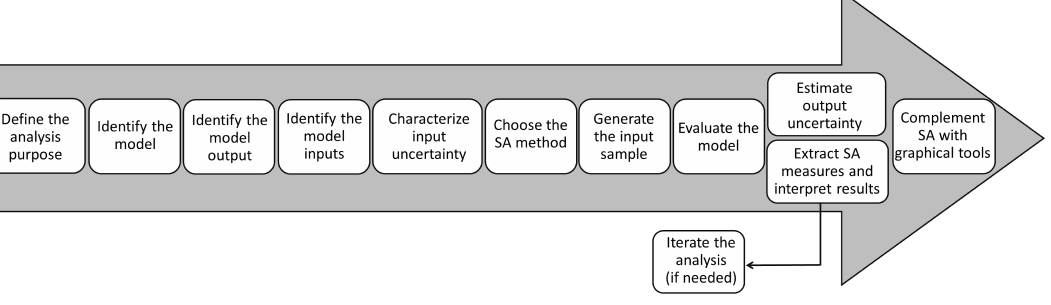
Figure 9. The suggested workflow for running global